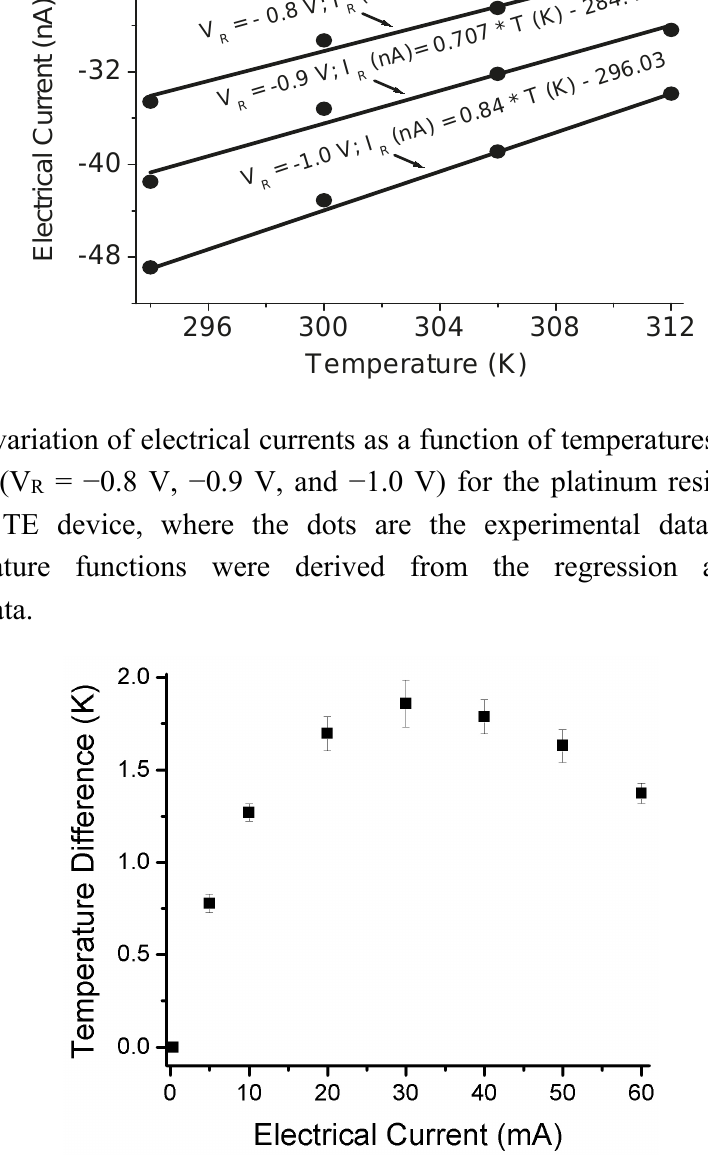
Figure 7. The variation of the temperature difference between the left and right sides of the in-plane Sb 2 Te 3 integrated thermoelectric device as a function of applied DC electrical